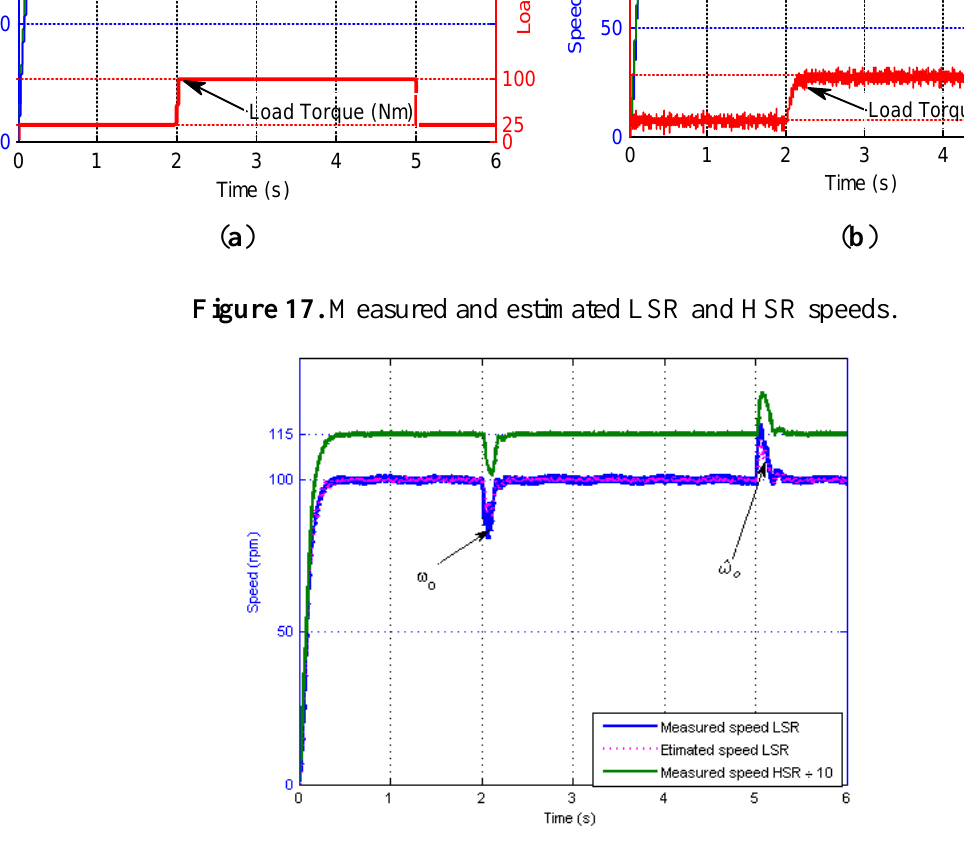
Figure 18. Measured currents